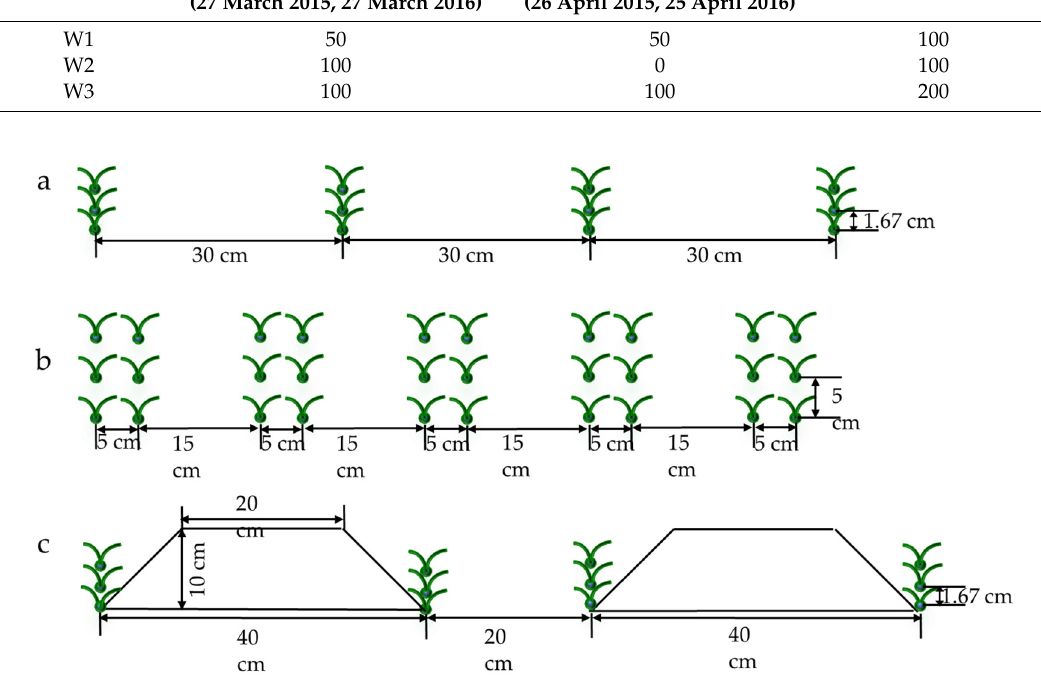
Figure 2. Schematic diagram of planting mode. ( a ) Uniform row (U), ( b ) double-double row (DD), ( c ) furrow-ridge row (F).